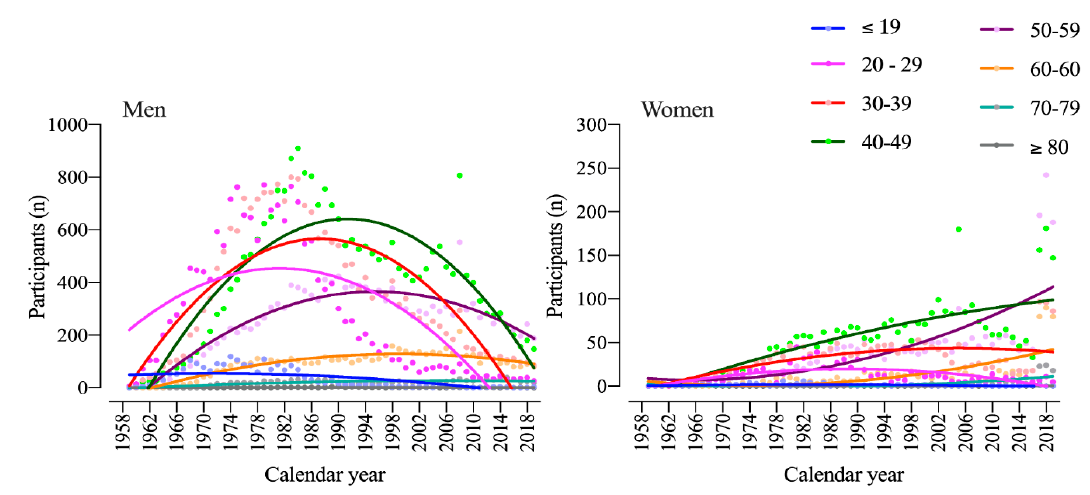
Figure 3. Participation by age group for men ( A ) and women ( B ) with second-order polynomial non-linear regressions.